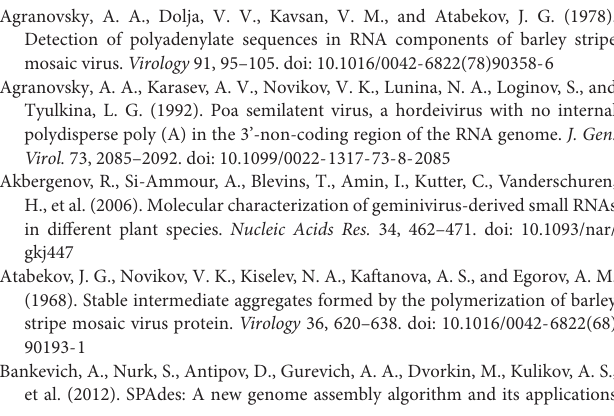
sequencing (sRNA-seq, dsRNA-seq and VANA-seq).